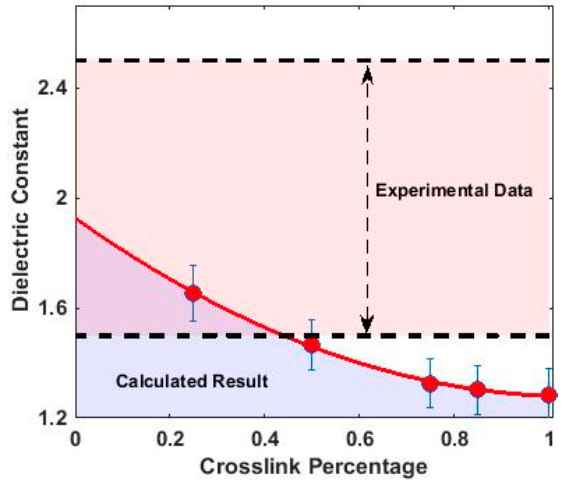
Figure 8. Graph of dielectric constant versus % crosslink.